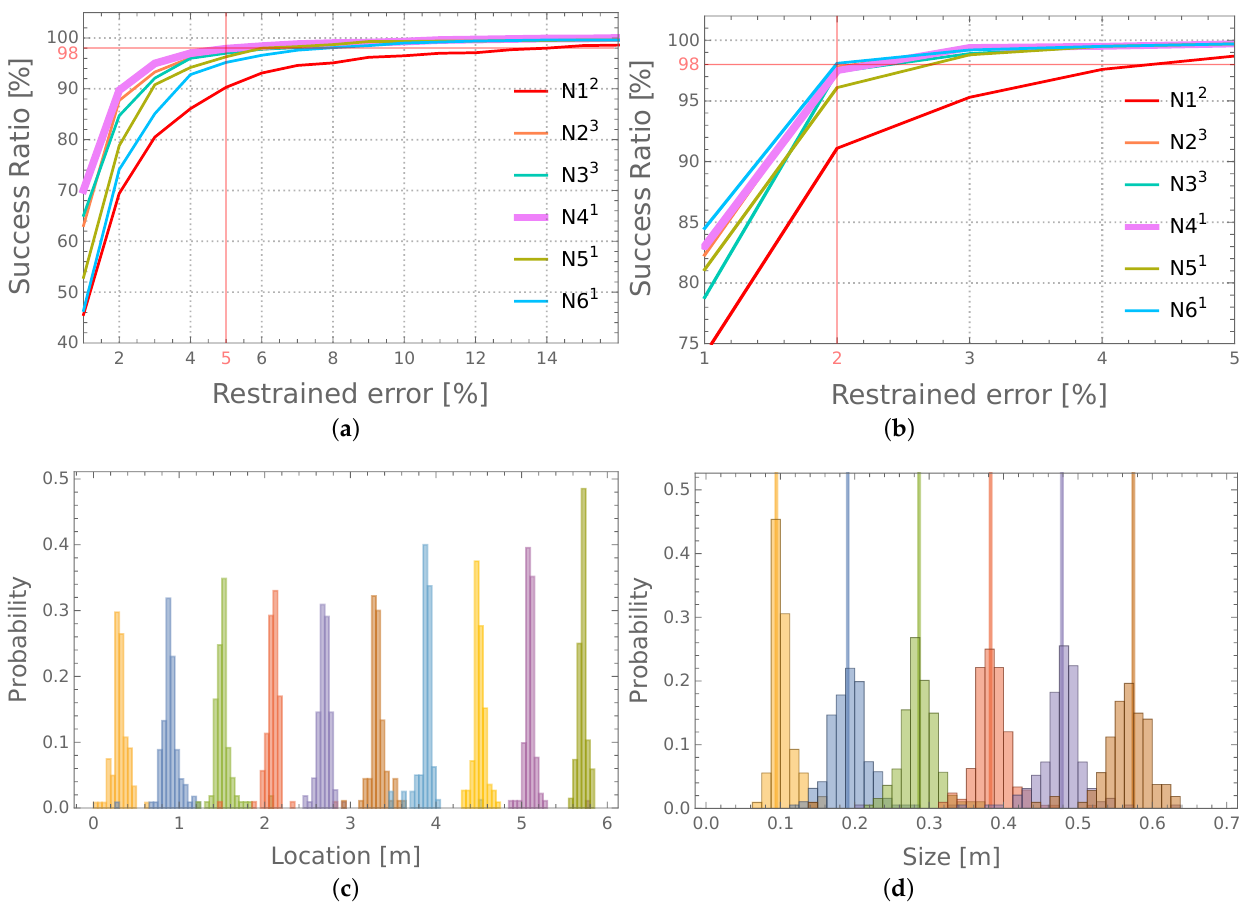
Figure 7. The histograms of errors of identification of degradated zone: ( a , c )—location; ( b , d